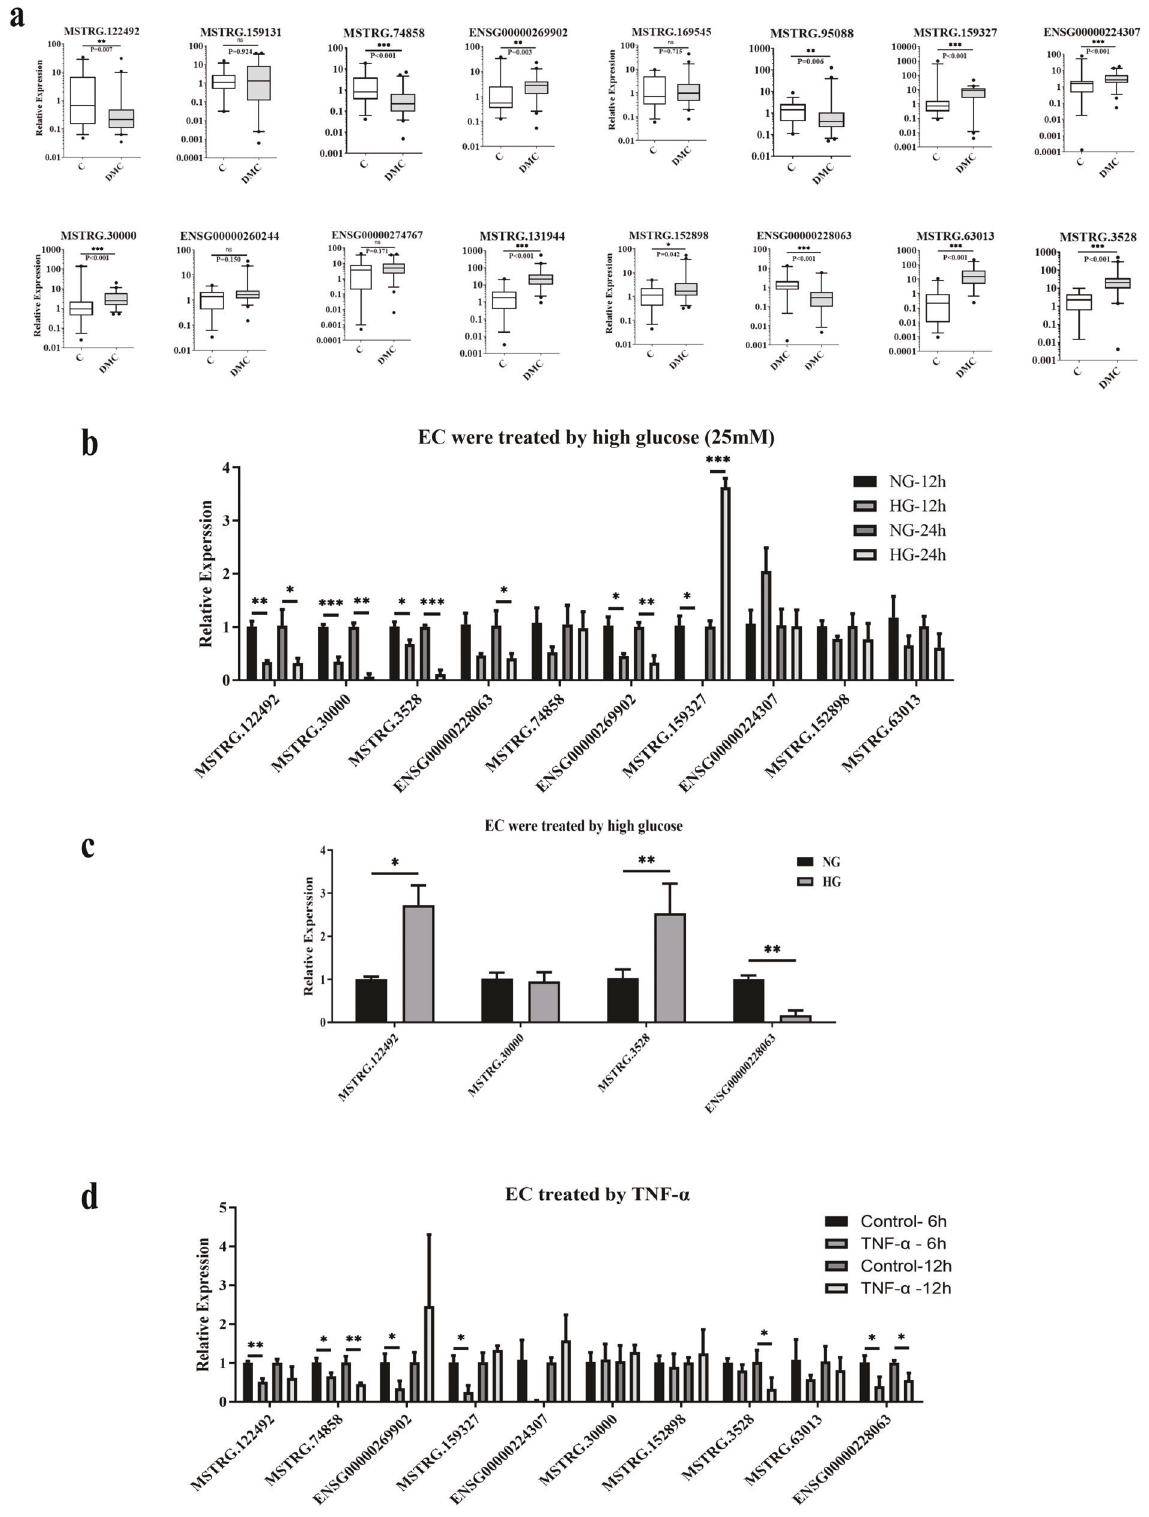
Fig. 3 Validation of lncRNAs in DMC patients and lncRNAs expression levels induced by high glucose and TNF- α in HUVEC (DMC n = 46, healthy control n = 36). a 12 of the 16 lncRNAs showed signi fi cant difference in expression levels between the DMC patients ( n = 46) and the healthy controls ( n = 36) analyzed by real-time PCR. b The lncRNAs expression in HUVEC after treated with 25 mM glucose for 12 h and 24 h. c The lncRNAs expression in HUVEC after treatment with 25 mM glucose and then resuming normal culture for 72 h. d The lncRNAs expression in HUVEC after being 3induced by TNF- α for 12 h and 24 h. “ NS ” : no signi fi cant difference; “ * ” indicated signi fi cant difference with p < 0.05, “ ** ” indicated p < 0.01 and “ *** ” indicated p < 0.001.